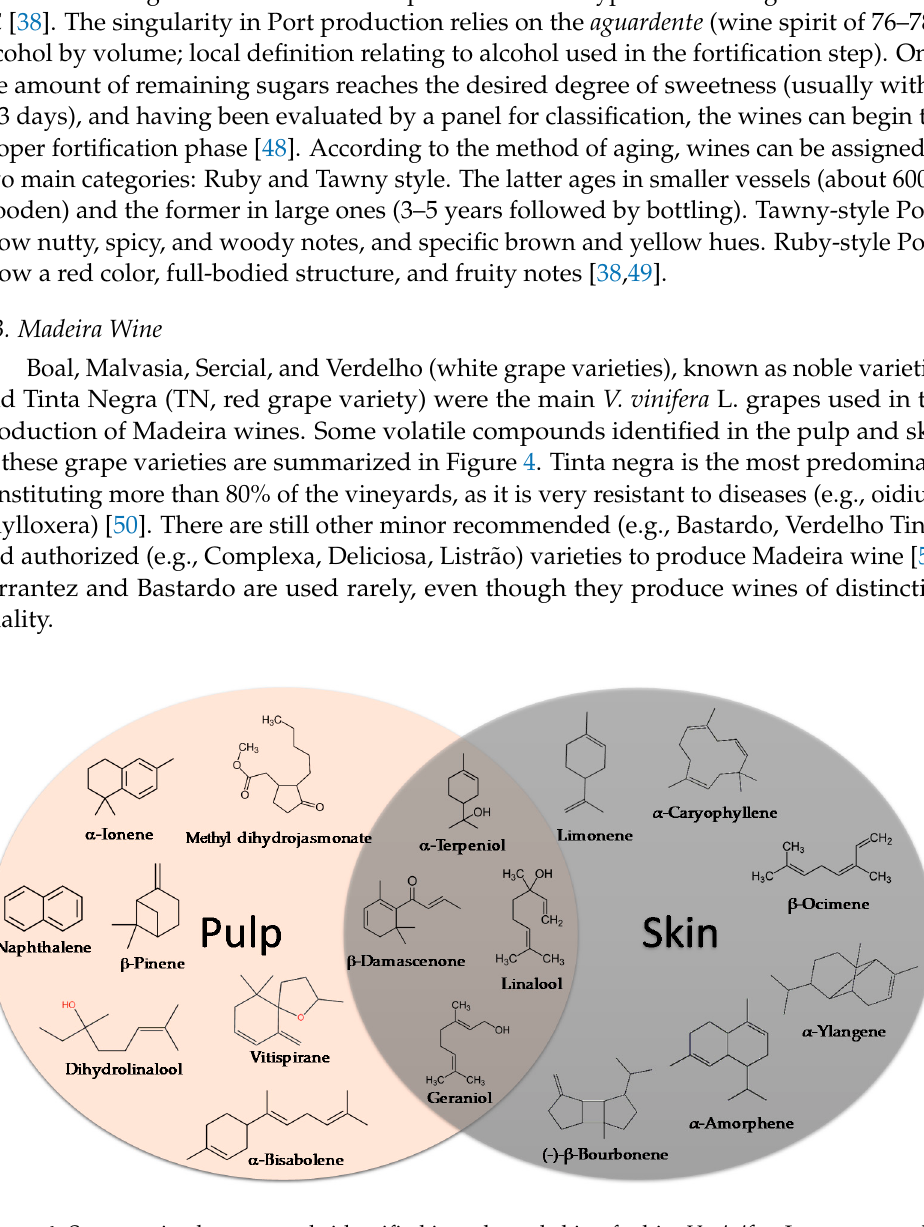
Figure 4. Some varietal compounds identified in pulp and skin of white V. vinifera L. grapes used in the production of Madeira wine [12,51].